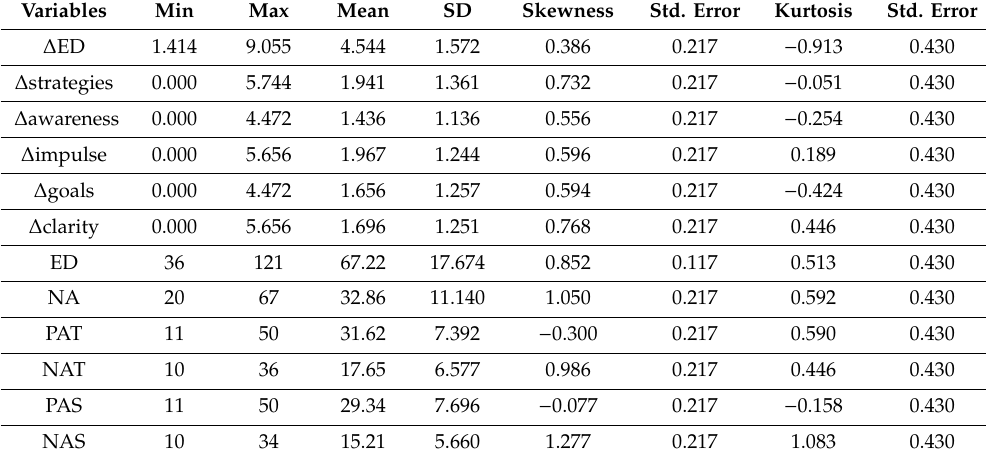
Table 4. Descriptive statistics / healthy group ( n =